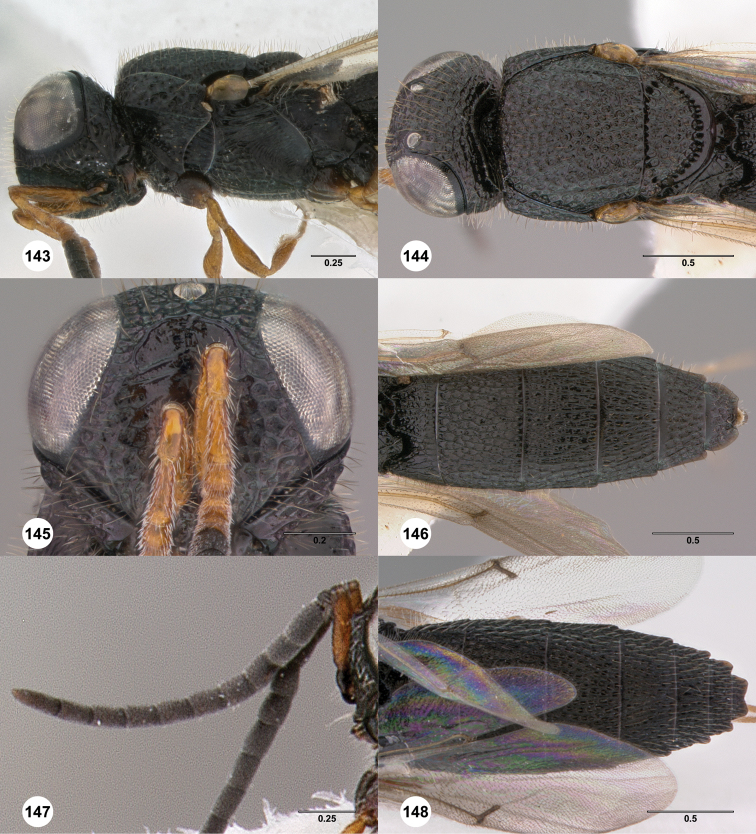
Oxyscelio incisurae sp. n., holotype female (OSUC 435942) 143 Head and mesosoma, lateral view 144 Head and mesosoma, dorsal view 145 Head, anterior view 146 Metasoma, dorsal view. Paratype male (OSUC 435949) 147 Antenna 148 Metasoma, dorsal view. Morphbank55